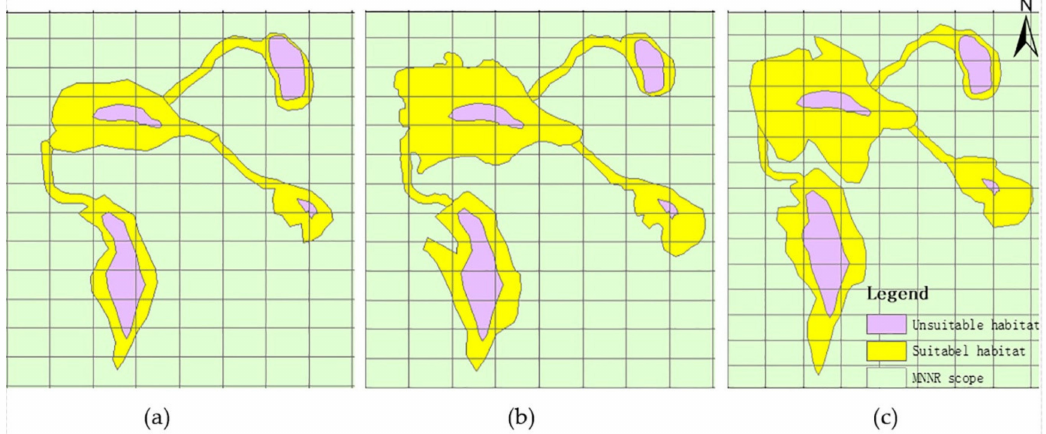
Figure 4. Schematic diagram of the habitat area restoration of some lakes under di ff erent water replenishment schemes. Panel ( a ) shows the recommended scheme, panels ( b ) and ( c ) show the lower bound and upper bounds of the optimal scheme under the high flood flow